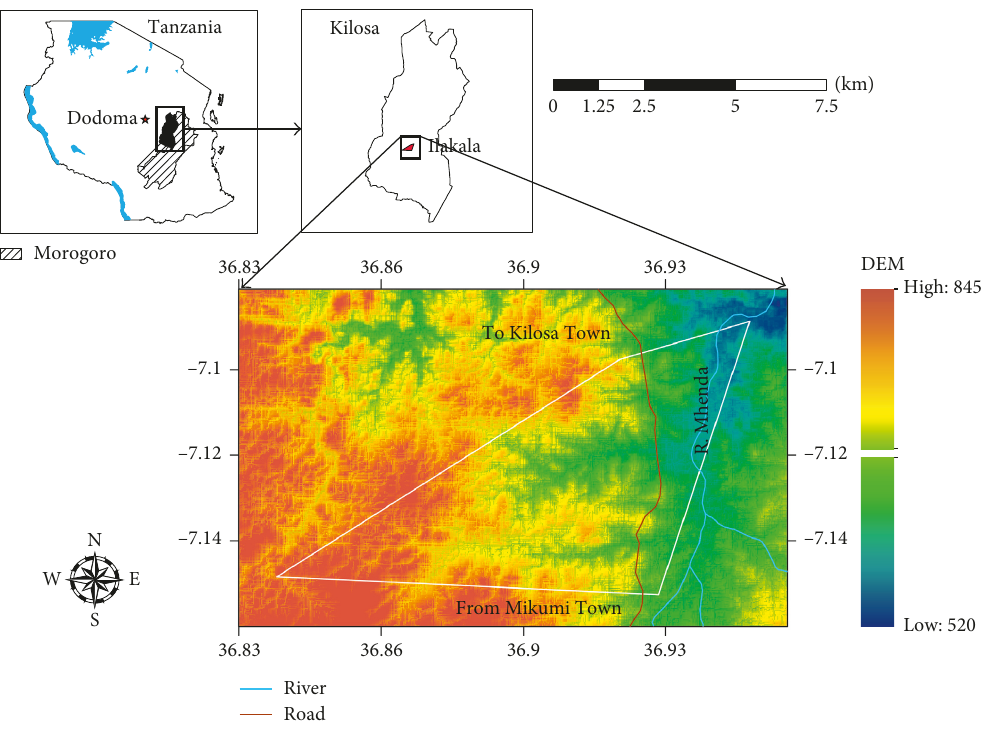
Figure 1: Location map of the Ilakala